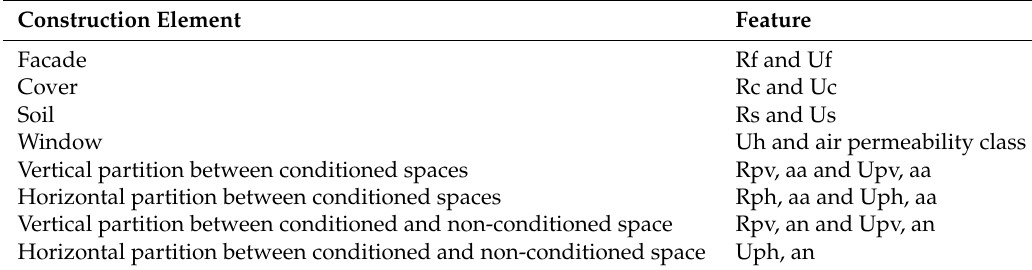
Table 5. Characteristics of the enclosures, partitions and